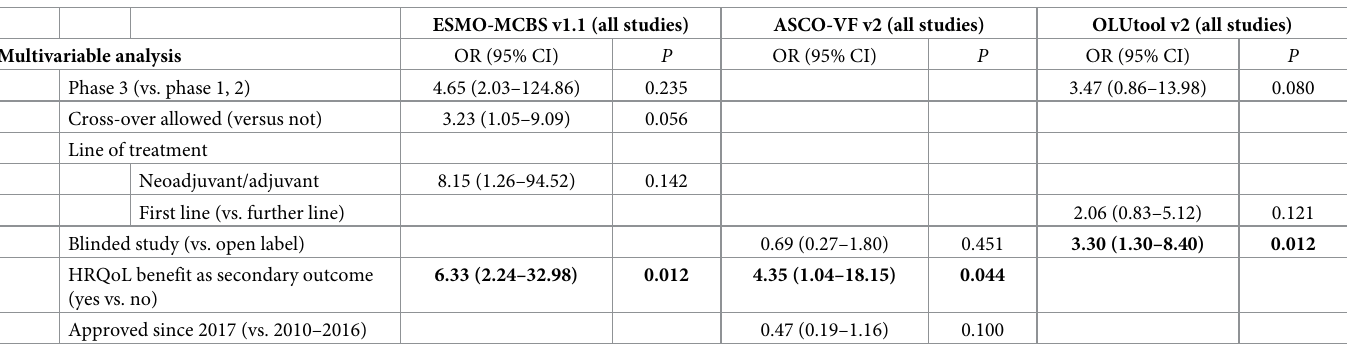
Table 3. Predictors for substantial clinical benefit on multivariable logistic regression for all studies.